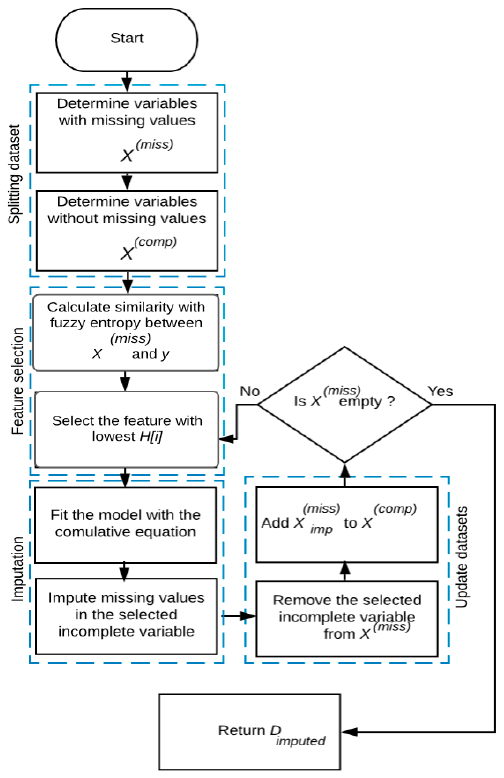
Figure 1. Proposed algorithm flow